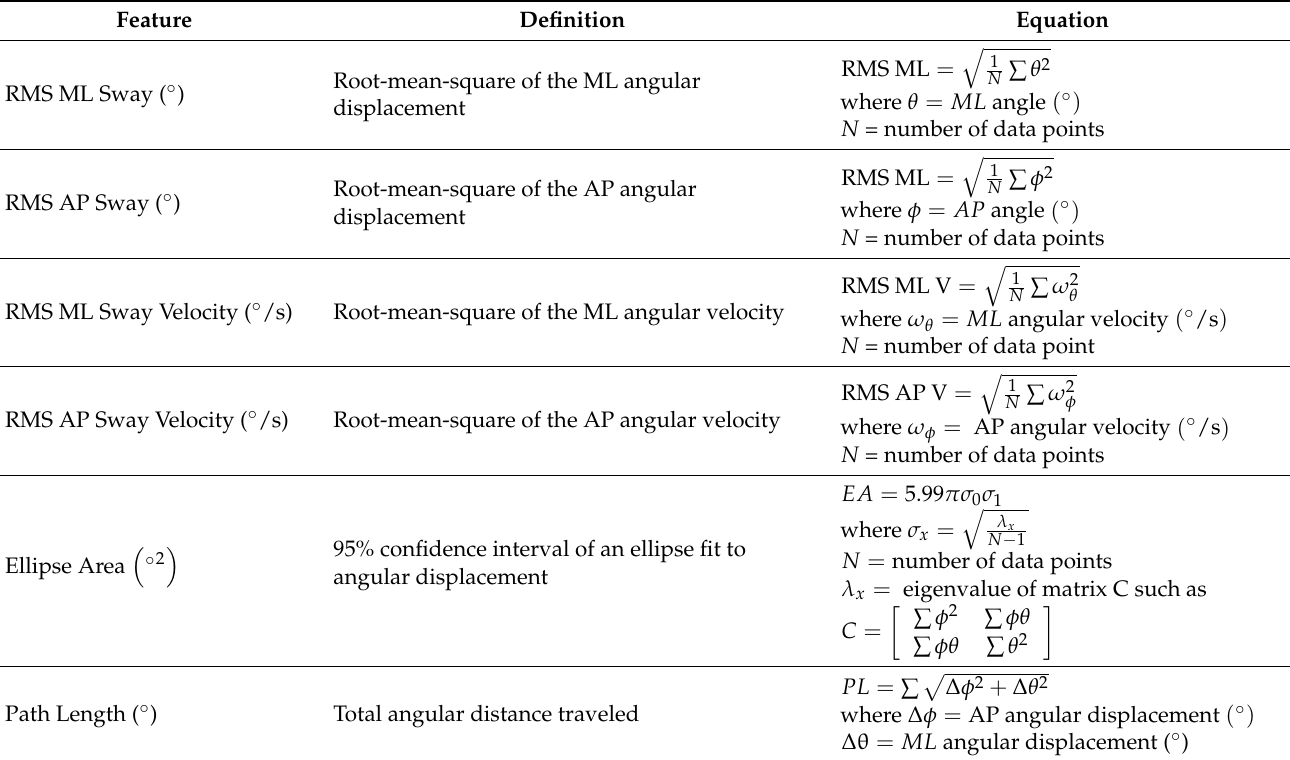
Table 4. Definitions of kinematic features extracted from the IMU sway